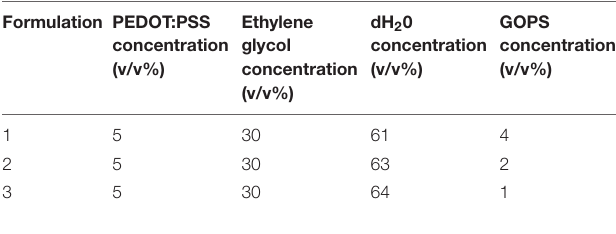
TABLE 1 | Print formulations used to determine biocompatibility. Formulation PEDOT:PSS